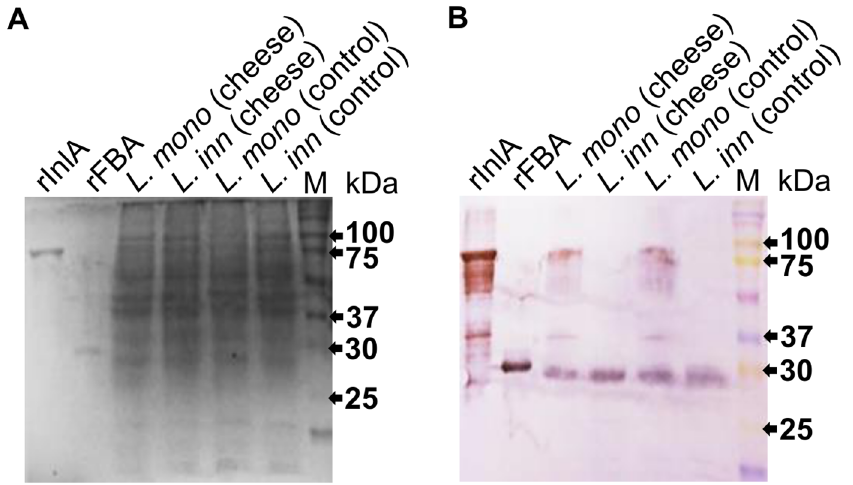
Fig 4. SDS-PAGE and Western blot of bacteria from artificially contaminated cheese. (A) SDS-PAGE (12%-acrylamide) showing the protein extracts from the bacteria after enrichment step using stomacher bags. Protein extracts from pure cultures were used as control. (B) Western blot using both mAb-3F8 and -2D12 on these protein extracts shows the expected detection bands: both InlA (88 kDa) and FBA (30 kDa) for the pathogenic strain; and only FBA (30 kDa) for the non-pathogenic. Purified rInlA and rFBA, and the pure cultures of L . monocytogenes and L . innocua were used as positive control for the